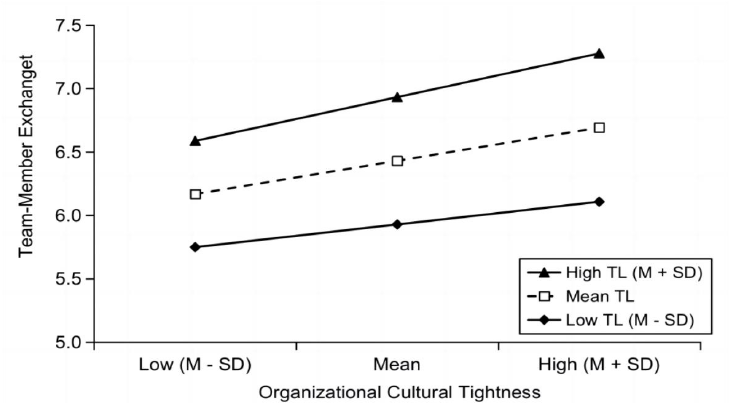
Figure 3. Simple slope analysis diagram.